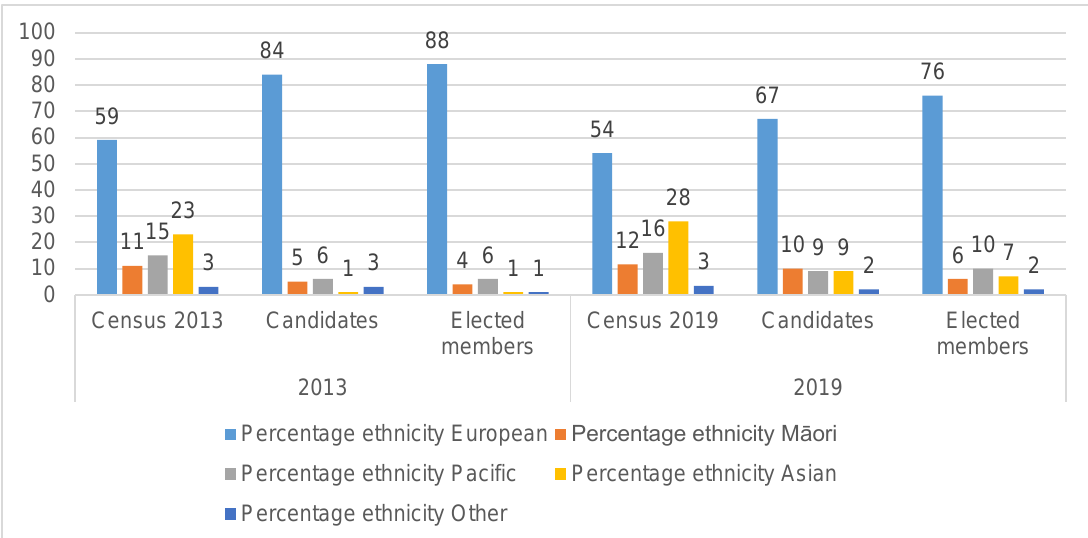
Figure 4: Candidate and elected member ethnicity compared to Census